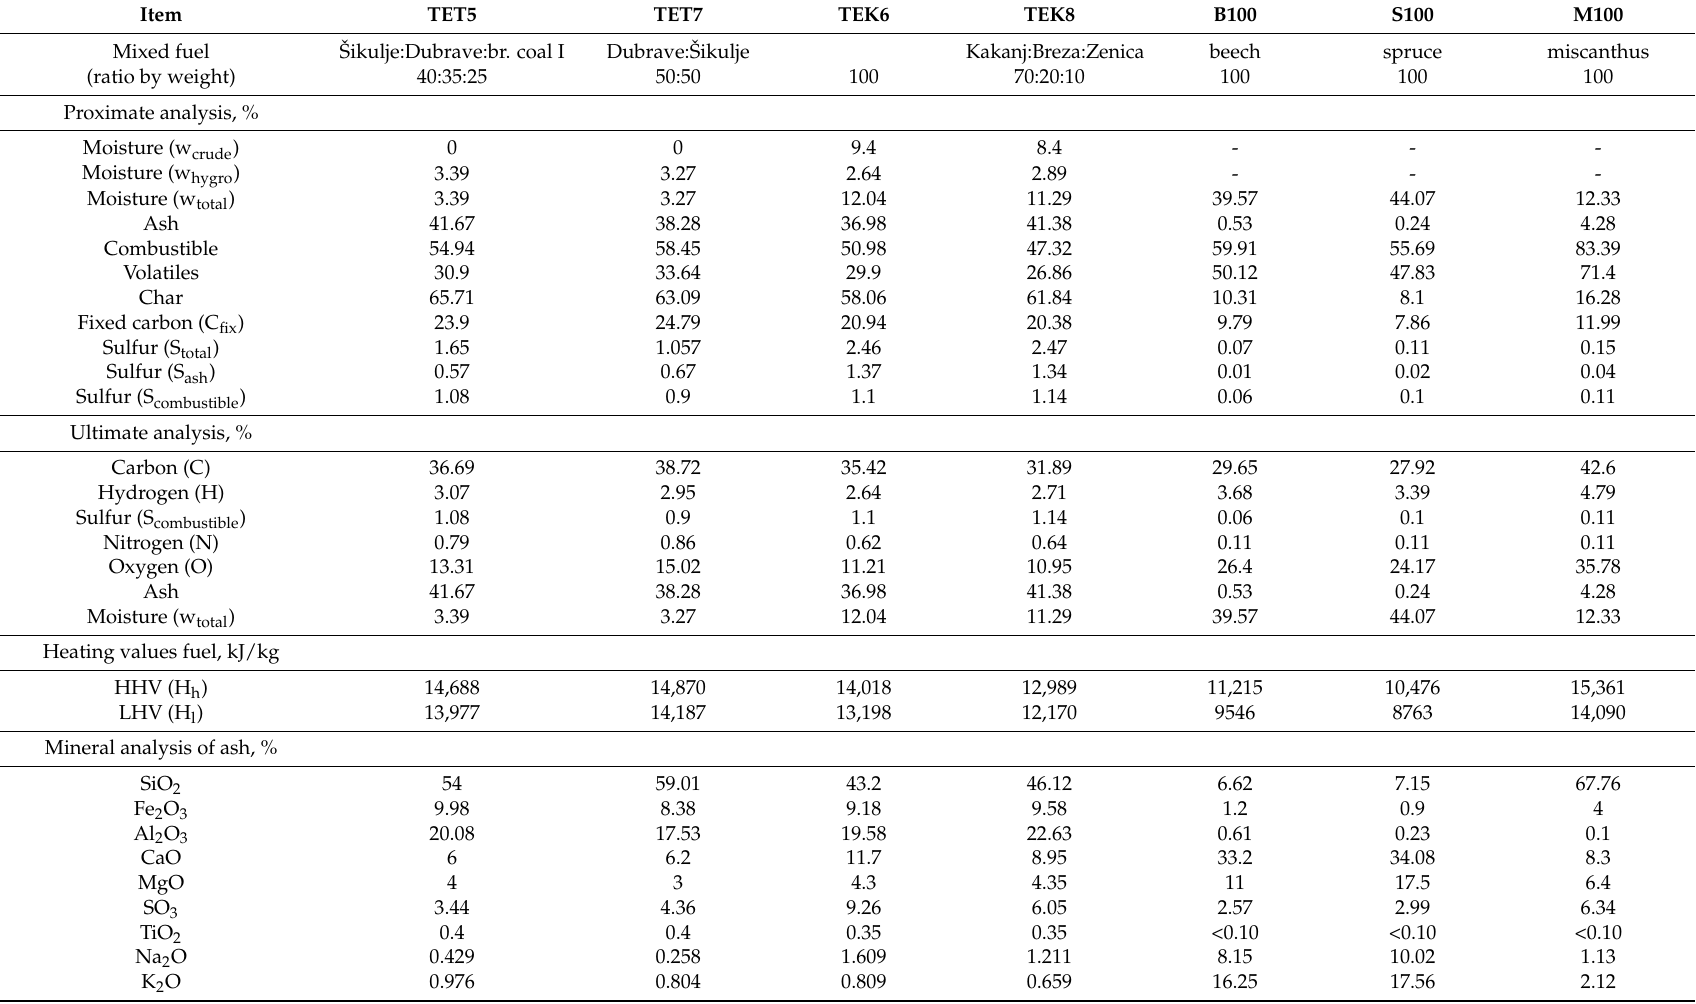
Table 2. The basic characteristics of the mixed coals from TPP Tuzla, TPP Kakanj and different